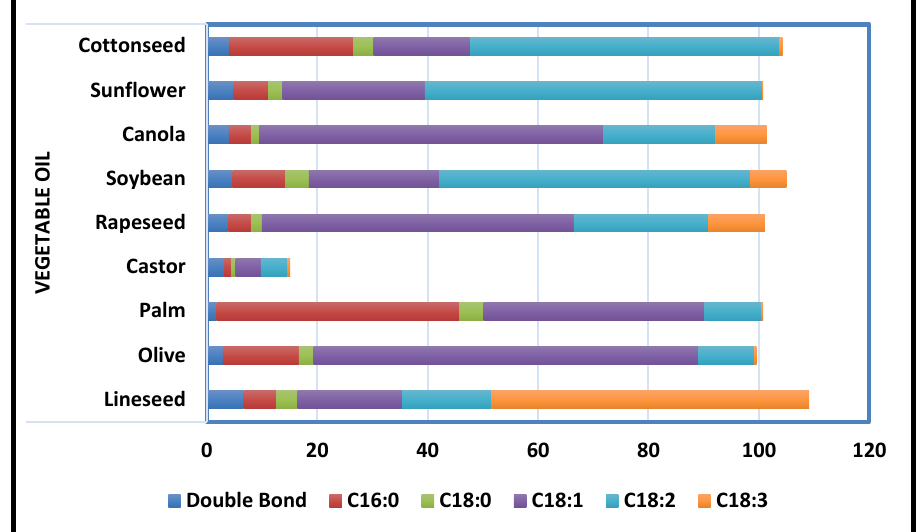
Figure 5. Common Vegetable Oils’ Degree of Unsaturation and Fatty Acid Composition [ 55].